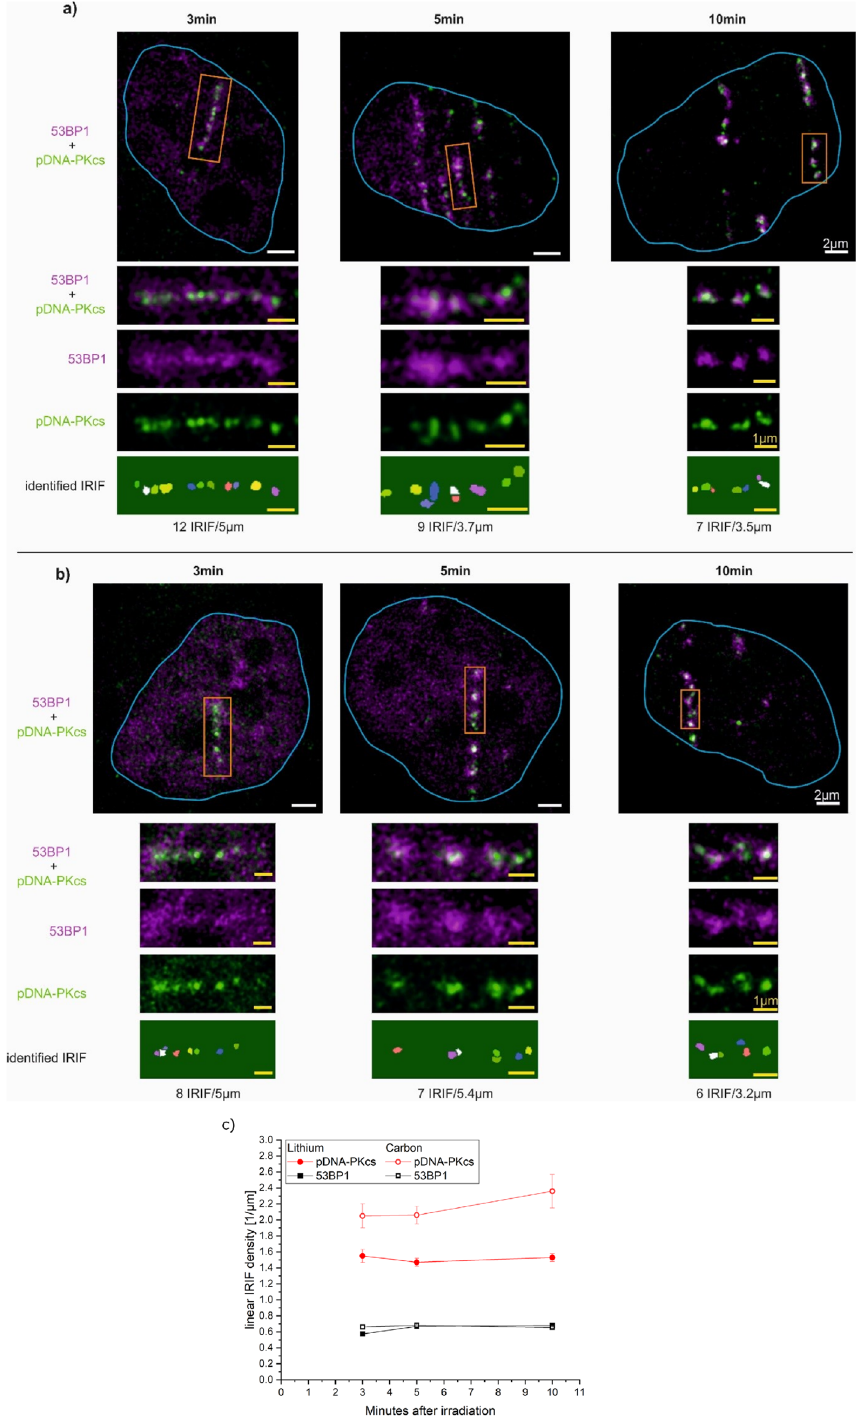
Figure 4. HeLa cells irradiated with ( a ) carbon and ( b ) lithium ions 3 min, 5 min, and 10 min after irradiation. Each track represents one ion traversal. The orange boxes are enlarged in the images below. The last row shows the identified IRIF and the number of IRIF and measured track length. ( c ) Linear IRIF density of pDNA-PKcs IRIF (red) and 53BP1 IRIF (black) 3 min, 5 min, and 10 min after carbon (open symbols) and lithium (filled symbols)